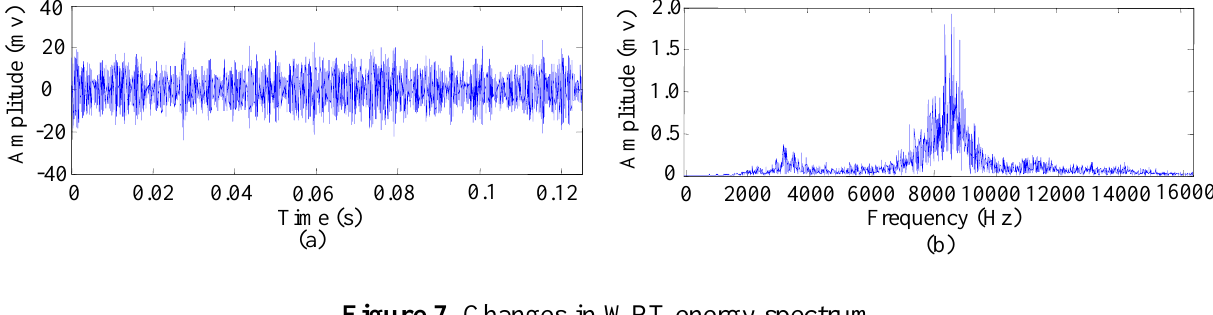
Figure 7. Changes in WPT energy spectrum.